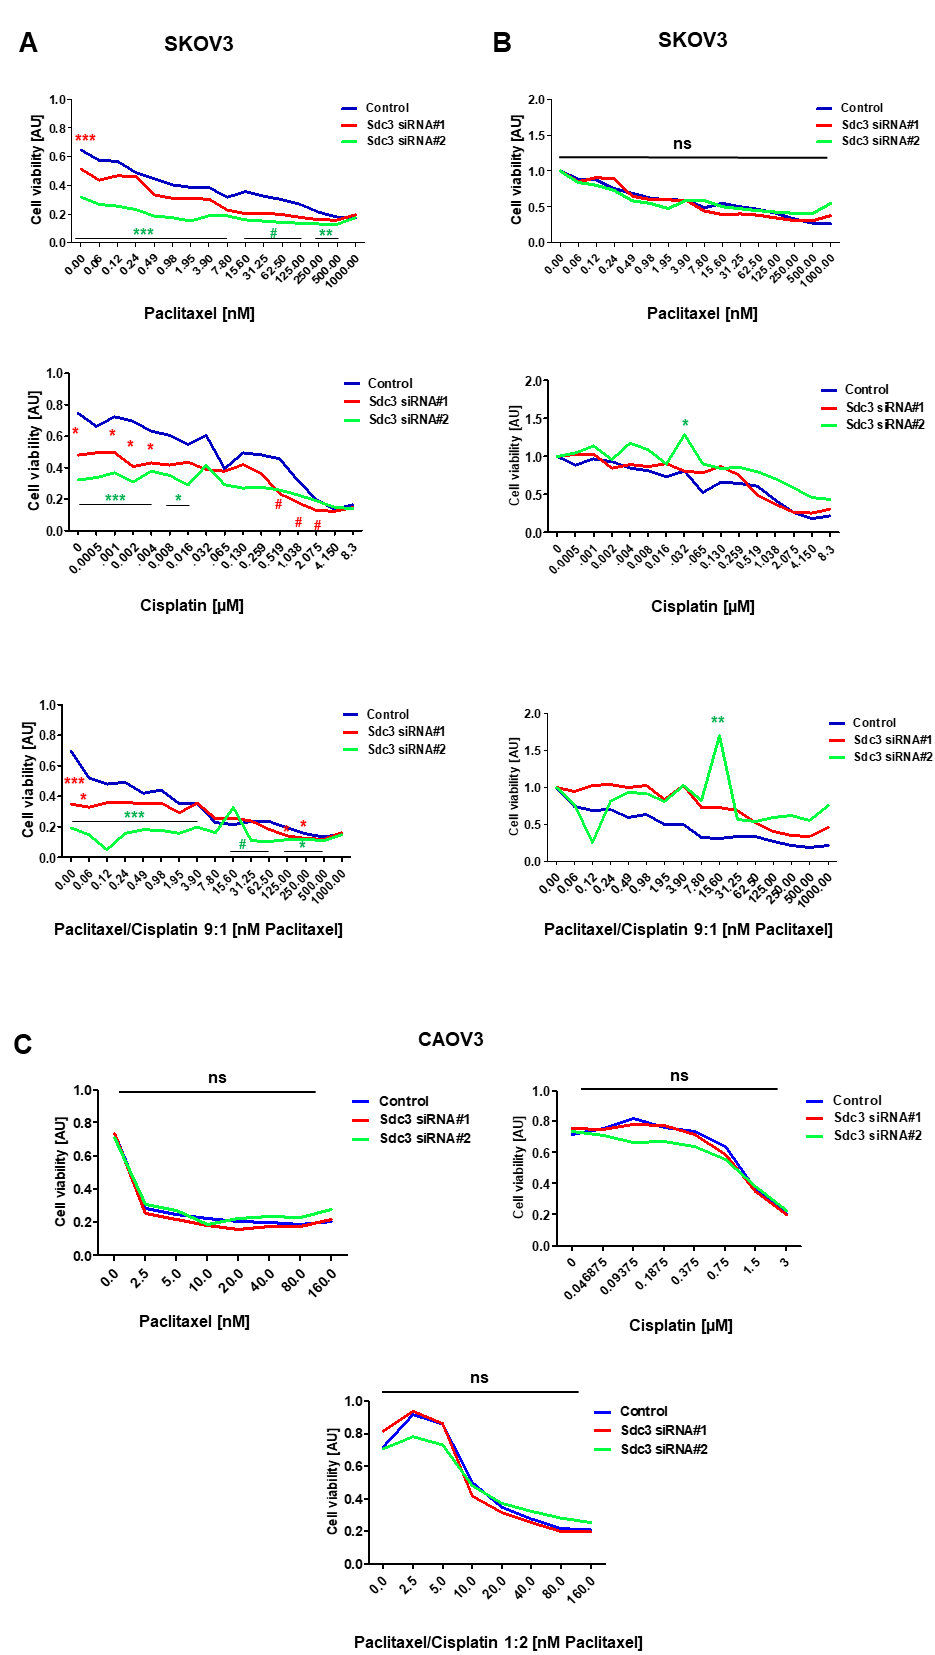
Figure 3. In vitro investigation of the chemotherapy response in SDC3-depleted ovarian cancer cell lines. ( A ) Response of SDC3 siRNA and control siRNA#1- and #2-treated SKOV3 cells subjected